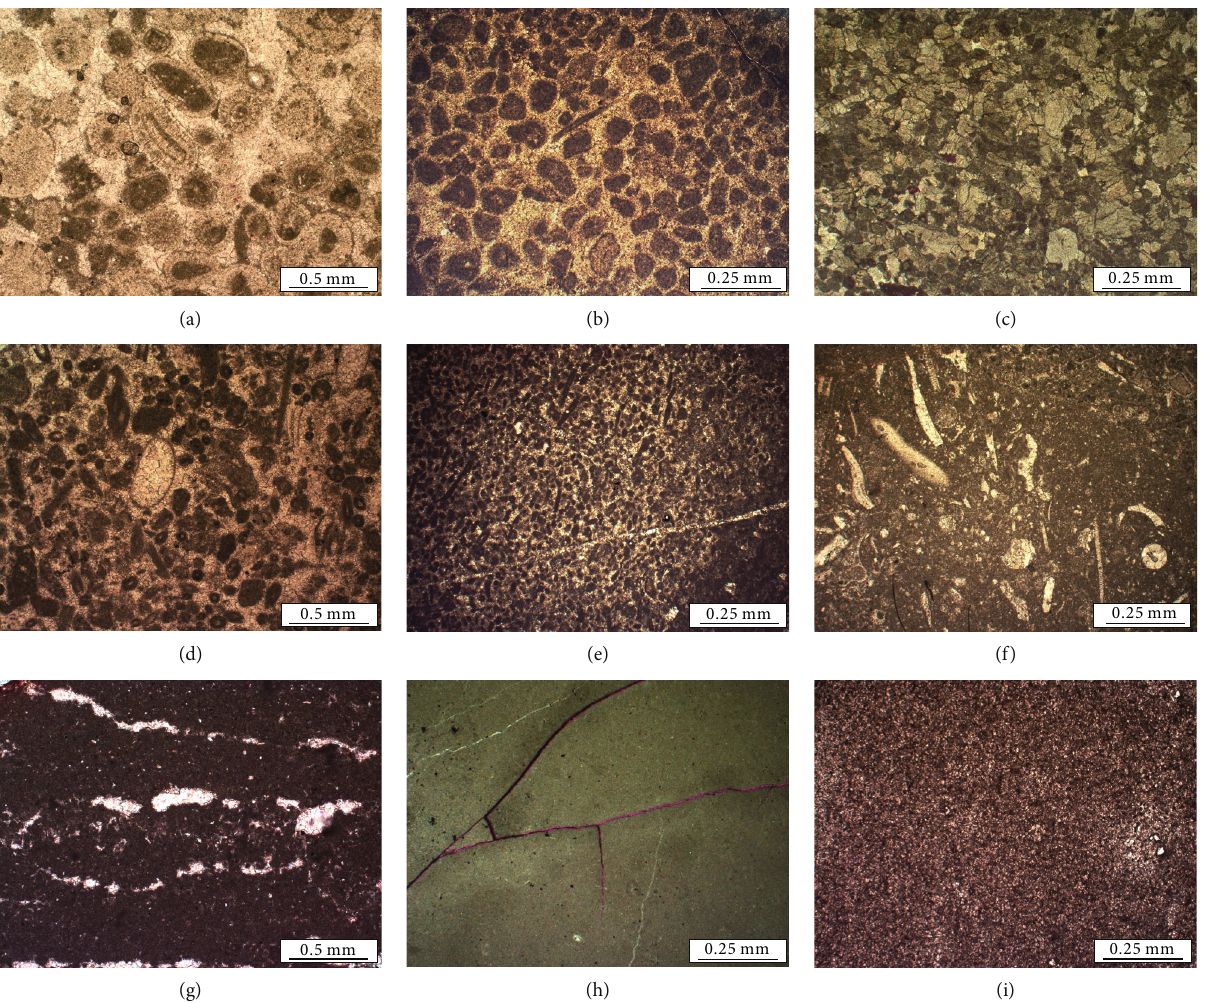
Figure 2: Main microfacies of Yingshan Formation in Tazhong area (Mf1-Mf9). (a) Mf1, oolitic grainstone, X3 well, 6650m. (b) Mf2, intraclast grainstone, X171. (c) Mf3, bioclastic grainstone, X16, 6417.54m. (d) Mf4, bioclastic intraclast grainstone, X452, 6370.53m. (e) Mf5, peloid packstone, X9, 6247.79m. (f) Mf6, bioclastic wackestone, X452, 6370.53m. (g) Mf7, bioclastic wackestone, X5, 6285m. (h) Mf8, mudstone, X41, 5540.85m, x25. (i) Mf9, microcrystal dolomite, X512,